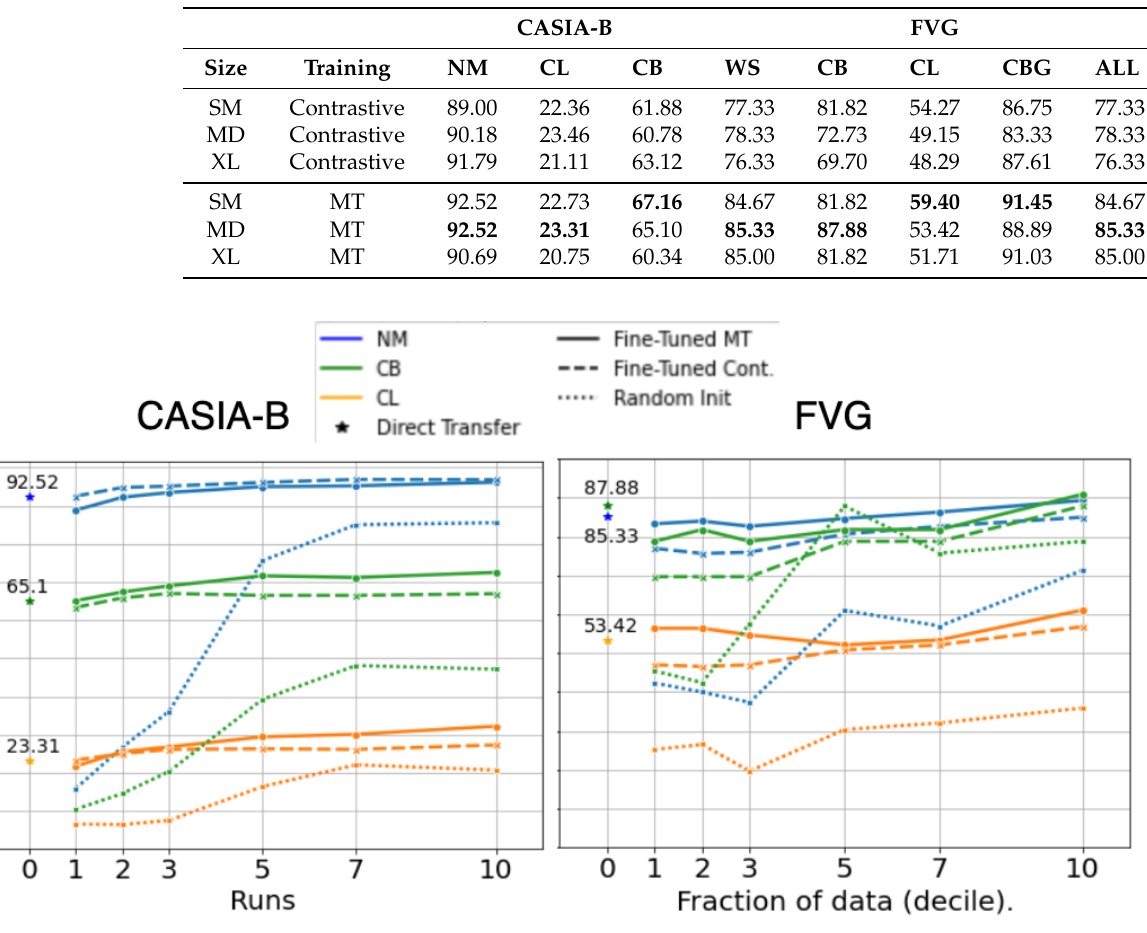
Table 3. GaitFormer direct transfer performance on gait recognition on CASIA-B and FVG datasets. We highlight in bold the best overall result for each dataset.